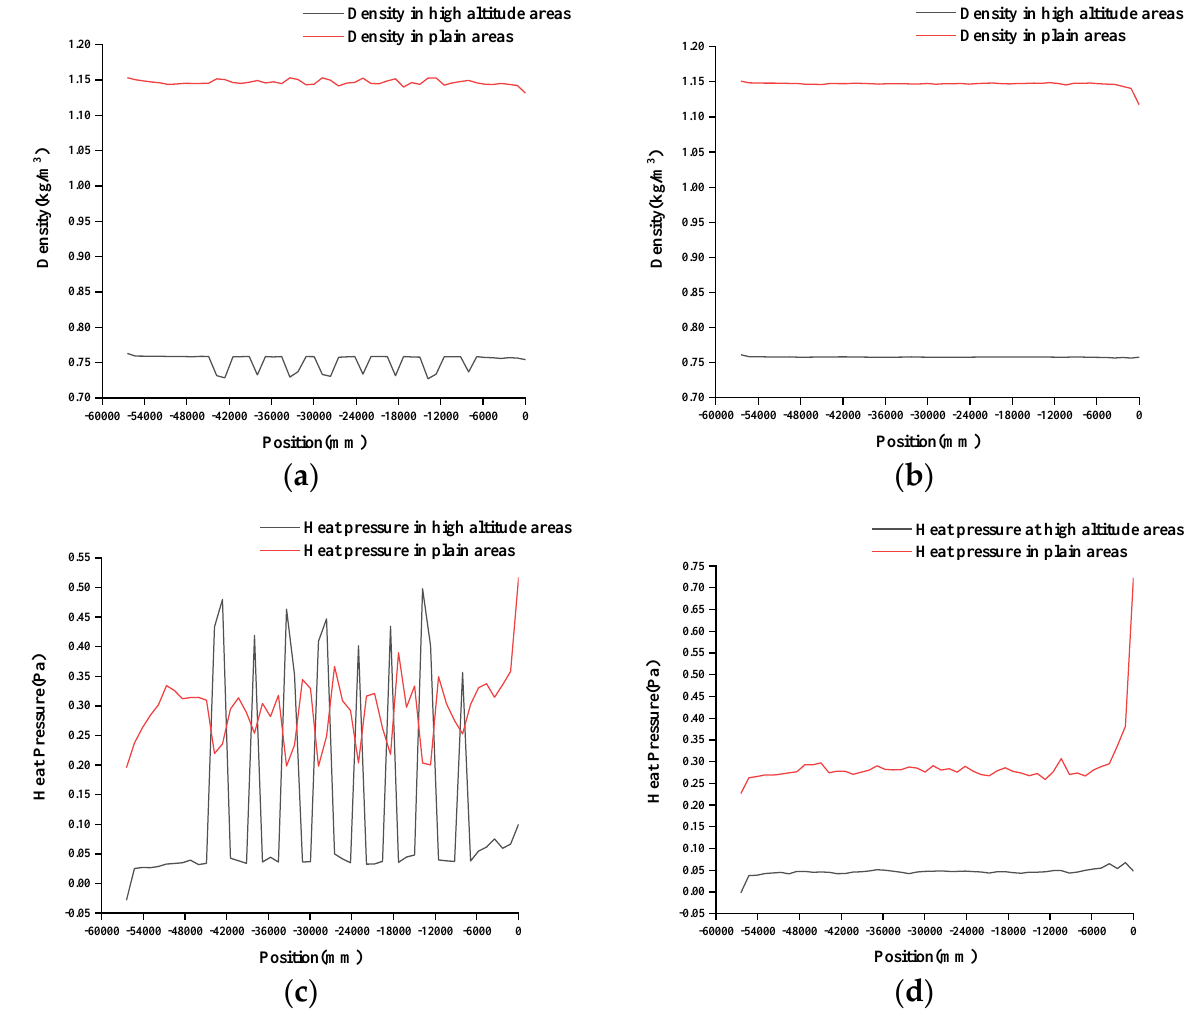
Figure 13. Variation in thermal pressure characteristic parameters in high − altitude and plain areas of: ( a ) x = 4000 mm, density; ( b ) x = 600 mm, density; ( c ) x = 4000 mm, heat pressure; ( d ) x = 600 mm, heat pressure.